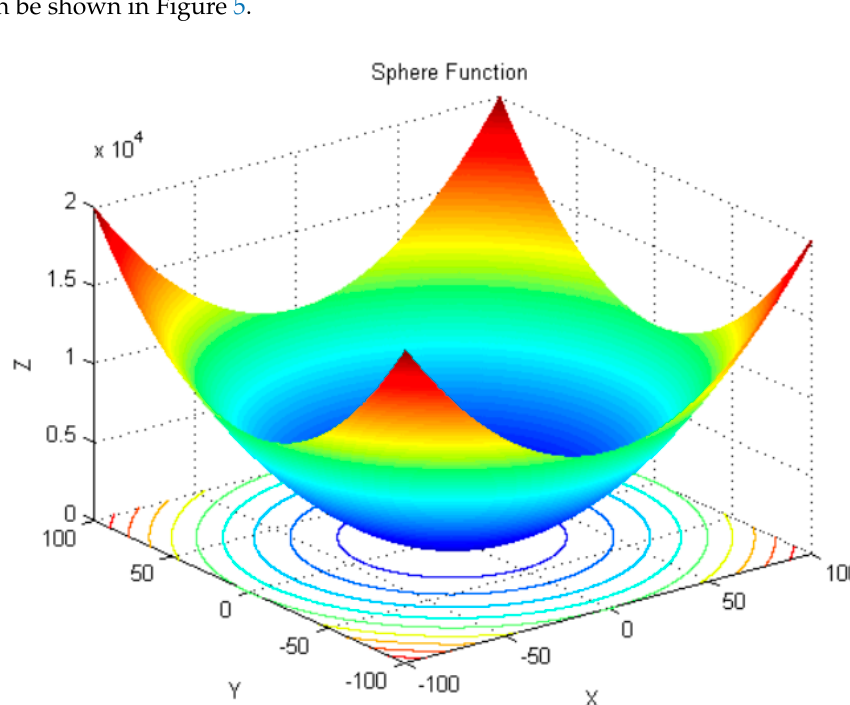
Figure 5. Three-dimensional graph of the Sphere